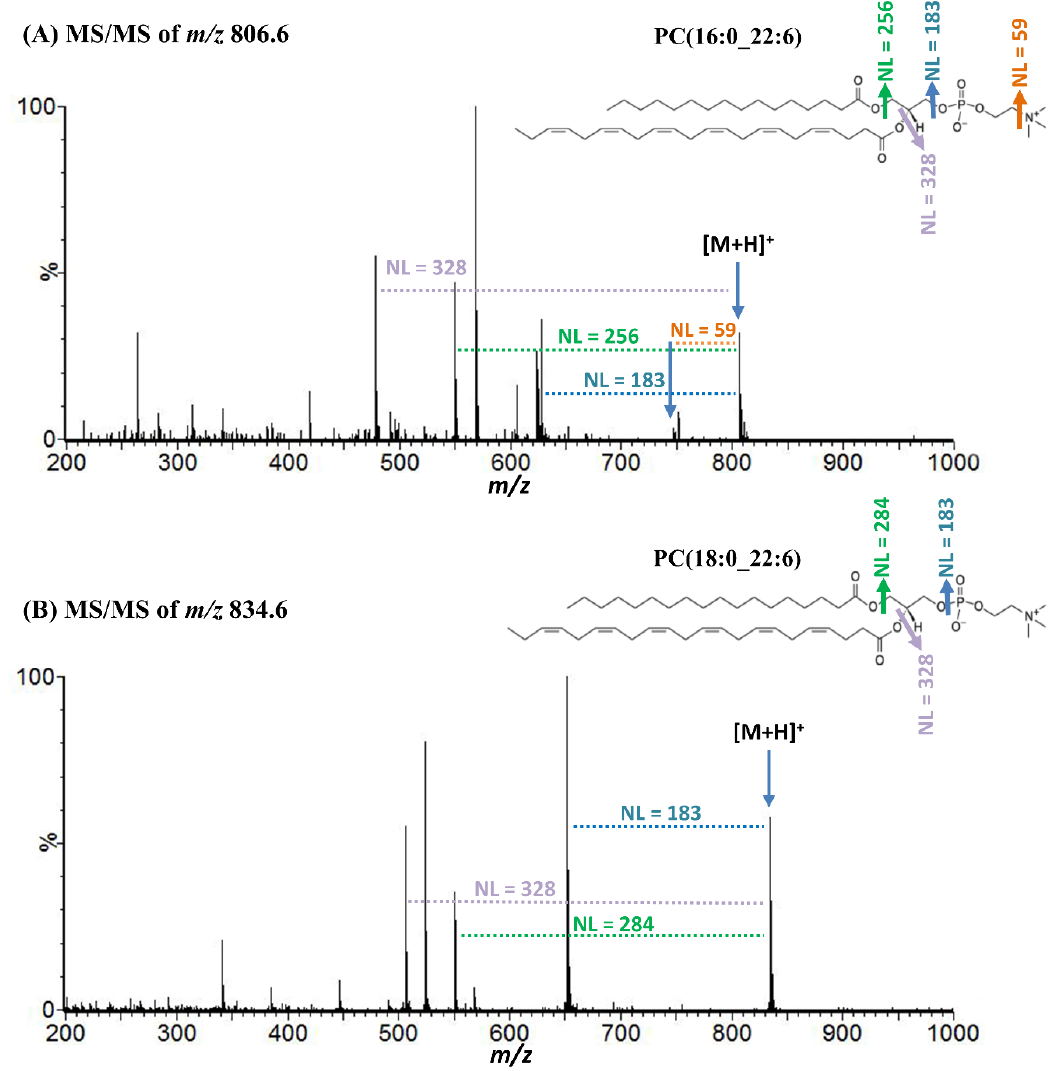
Figure 2. Representative LC-ESI-MS/MS spectra of m/z 806.6 ( A ) and 834.6 ( B ) in positive ionization mode. NL; neutral loss.